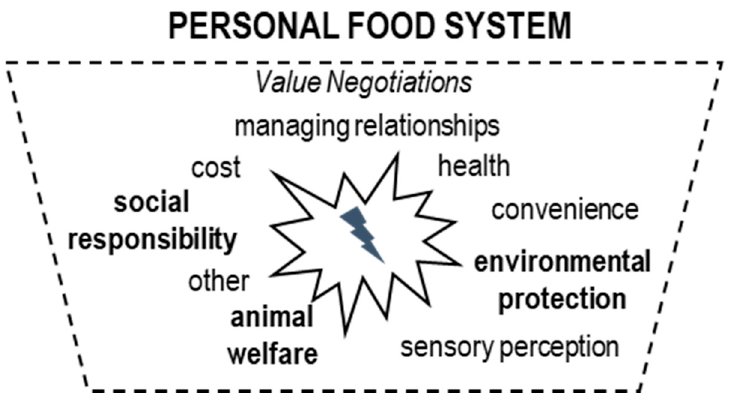
Figure 3. Value negotiations in the personal food system of consumers involved with sustainability.